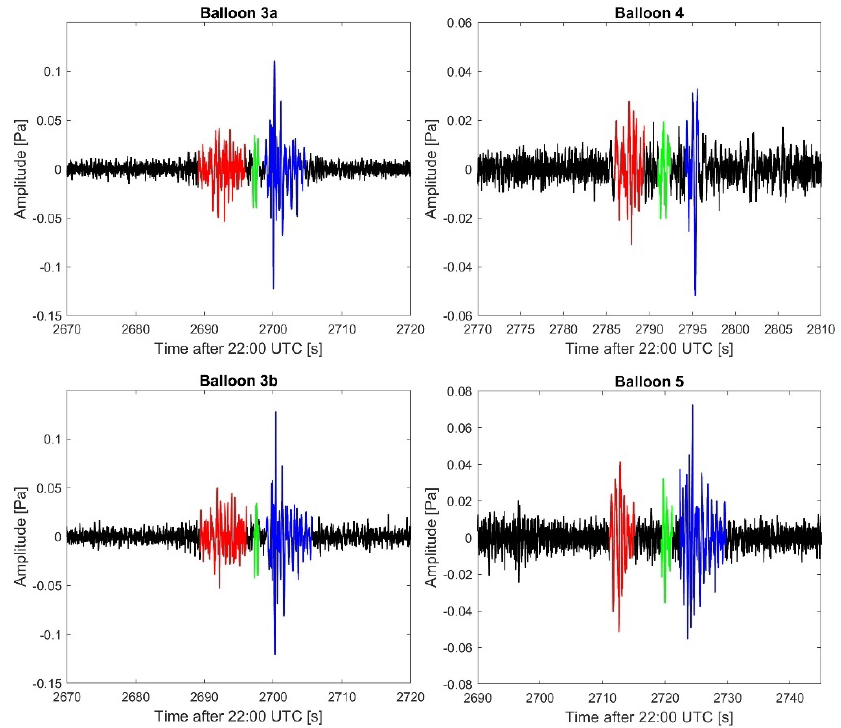
Figure 6. Zoomed-in view of the signals. The colored segments are included for visual purposes to delineate the individual arrival phases. Note that the signals are not aligned, nor do they have the same amplitude and time scale.